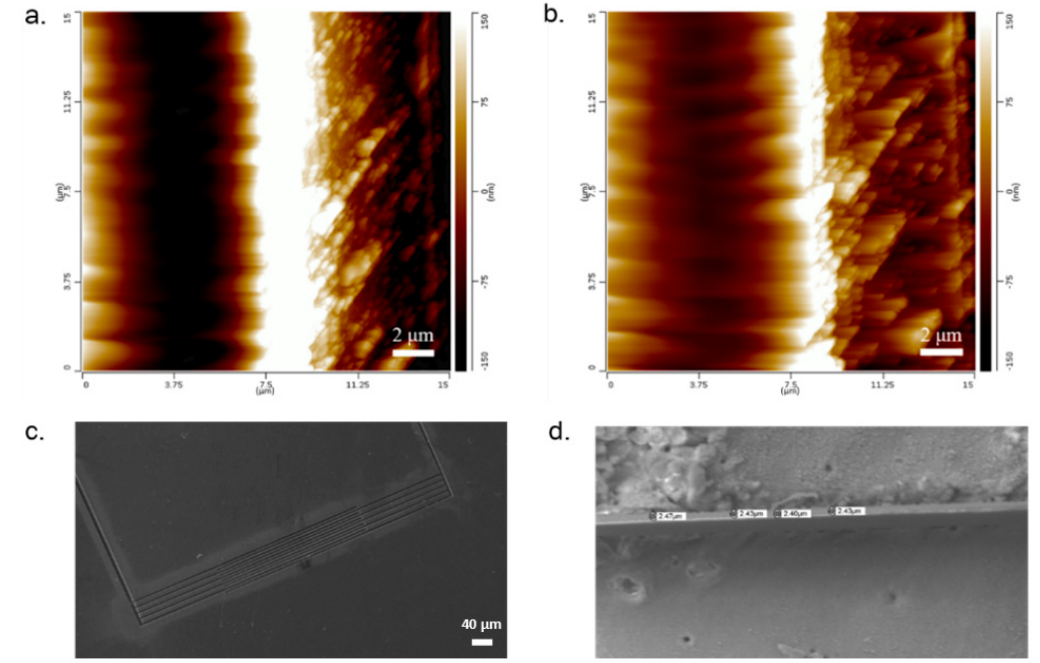
Figure 10. Images of sub-5 µm trace widths in Kapton ® . ( a ) Atomic force microscopy (AFM) image of 3.5 µm trace width (white area). ( b ) AFM image of 1.5 µm trace width (white area). ( c ) SEM image of full comb finger electrode structure (approx. 5 µm trace width). ( d ) SEM image of shadow mask feature of approximately 2.43 µm trace width.